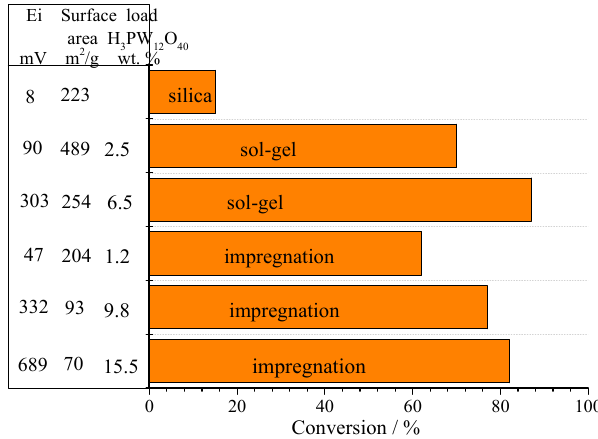
Figure 7. Effect of acidity strength, surface area, synthesis method, and H 3 PW 12 O 40 /SiO 2 catalyst loading on the conversion of glycerol esterification reactions with acetic acid (adapted from ref. [50]). Reaction conditions: molar ratio of glycerol to acetic acid (1:16); temperature (393 K); catalyst (2.0 g). Acidity and surface area are key aspects for an active heterogeneous catalyst. Indeed, lower surface area. Conversely, the catalyst with the highest surface area also achieved a